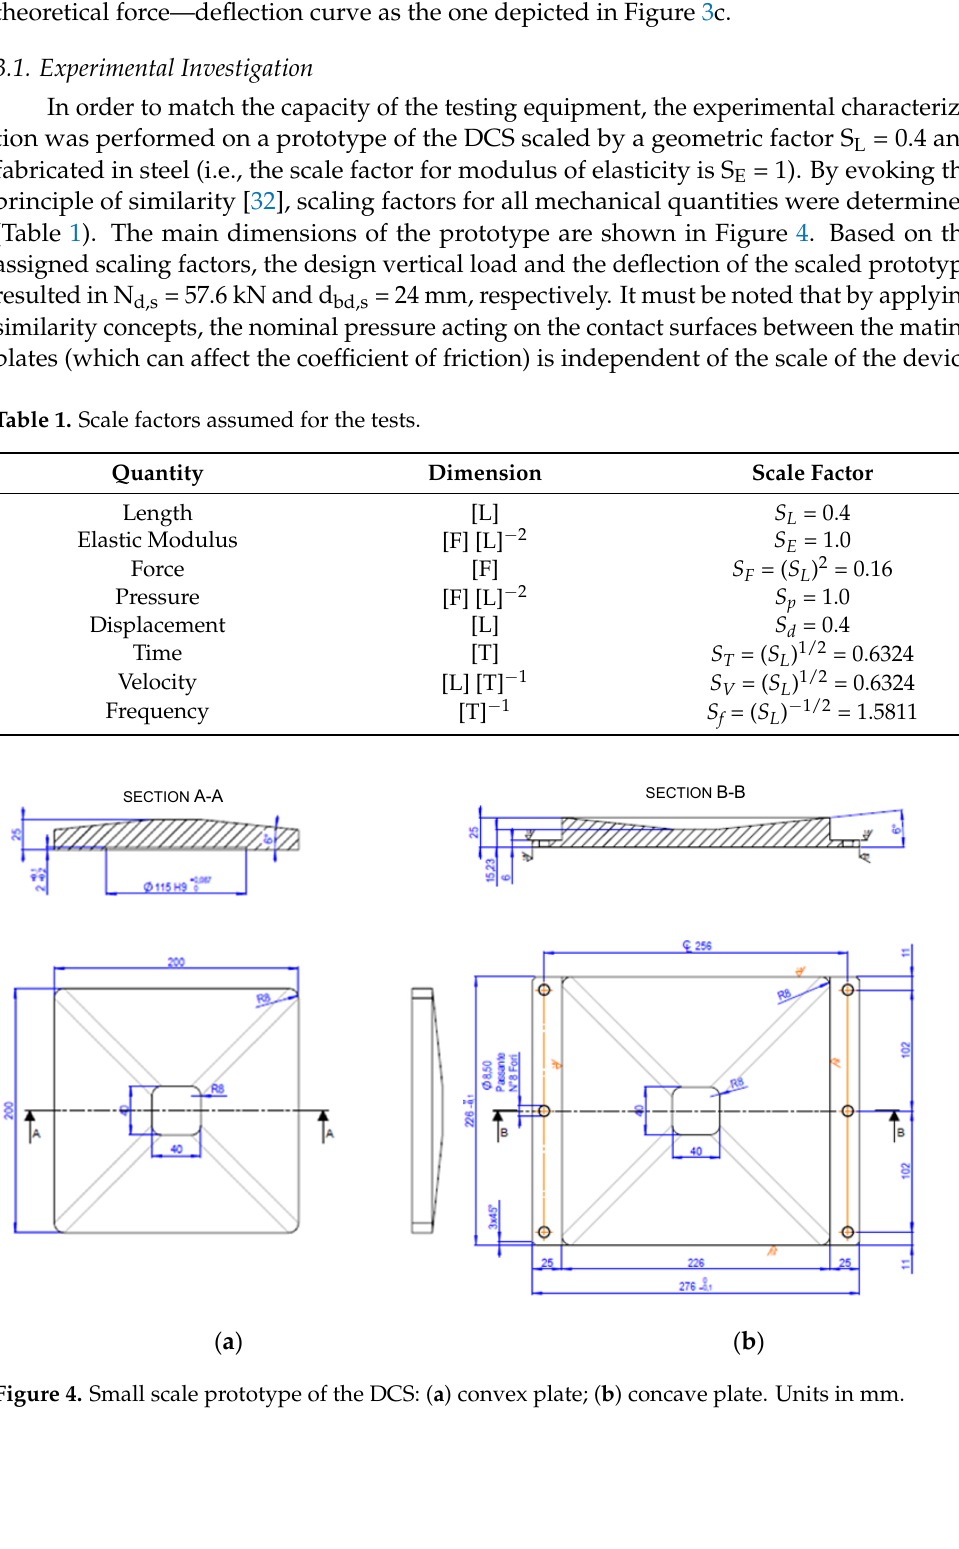
Figure 3. Backbone curves of the dissipative connection systems: ( a ) μ < tan( α ); ( b ) μ > tan( α ); ( c ) μ = tan( α ).